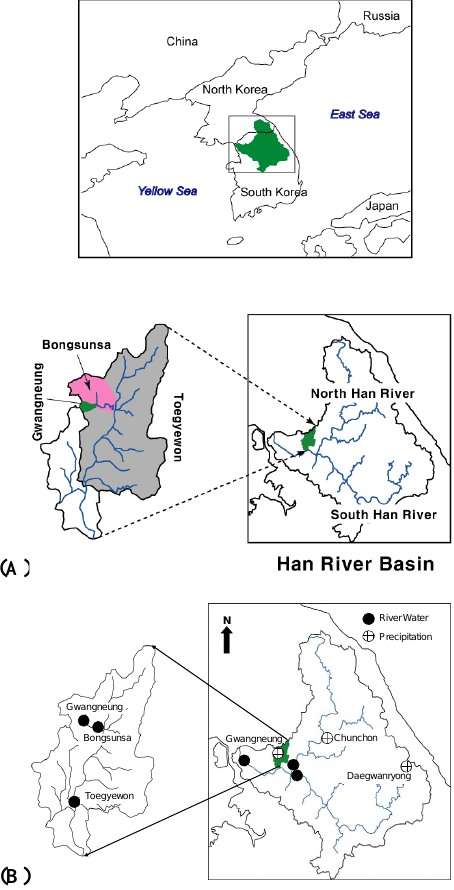
Fig. 1. Maps showing (A) the Han River Basin and its tributaries (adopted from Kim et al., 2006), (B) sampling